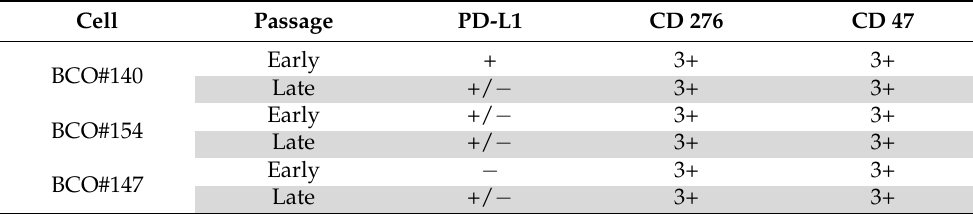
Table 2. Expression of immune regulatory antigens on bladder cancer organoids in chamber slides 2.